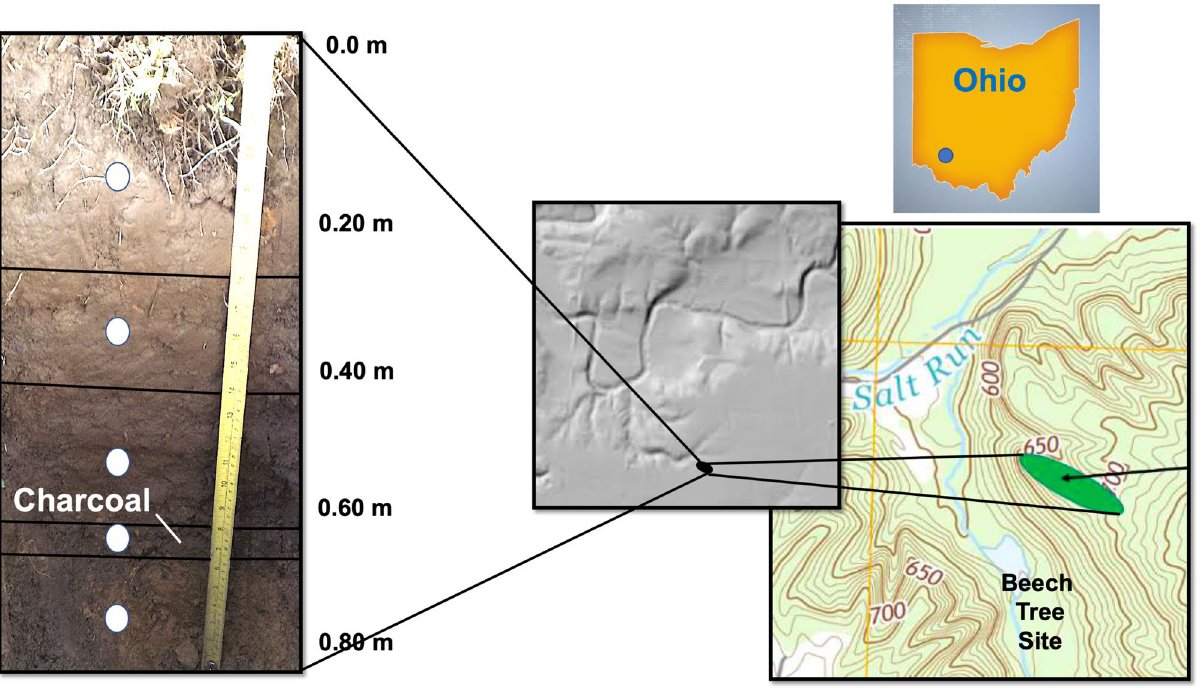
Figure 6. The location, stratigraphy, and location of sediment sample sites (white circles) of the Beech Tree village site, Clermont County, Ohio. Kenneth Barnett Tankersley used Microsoft PowerPoint for Mac Version 16.41 (www. micro soft. com) to create this figure. The GIS map was produced in ESRI ArcGIS 10.3.1 software (www. esri. com).